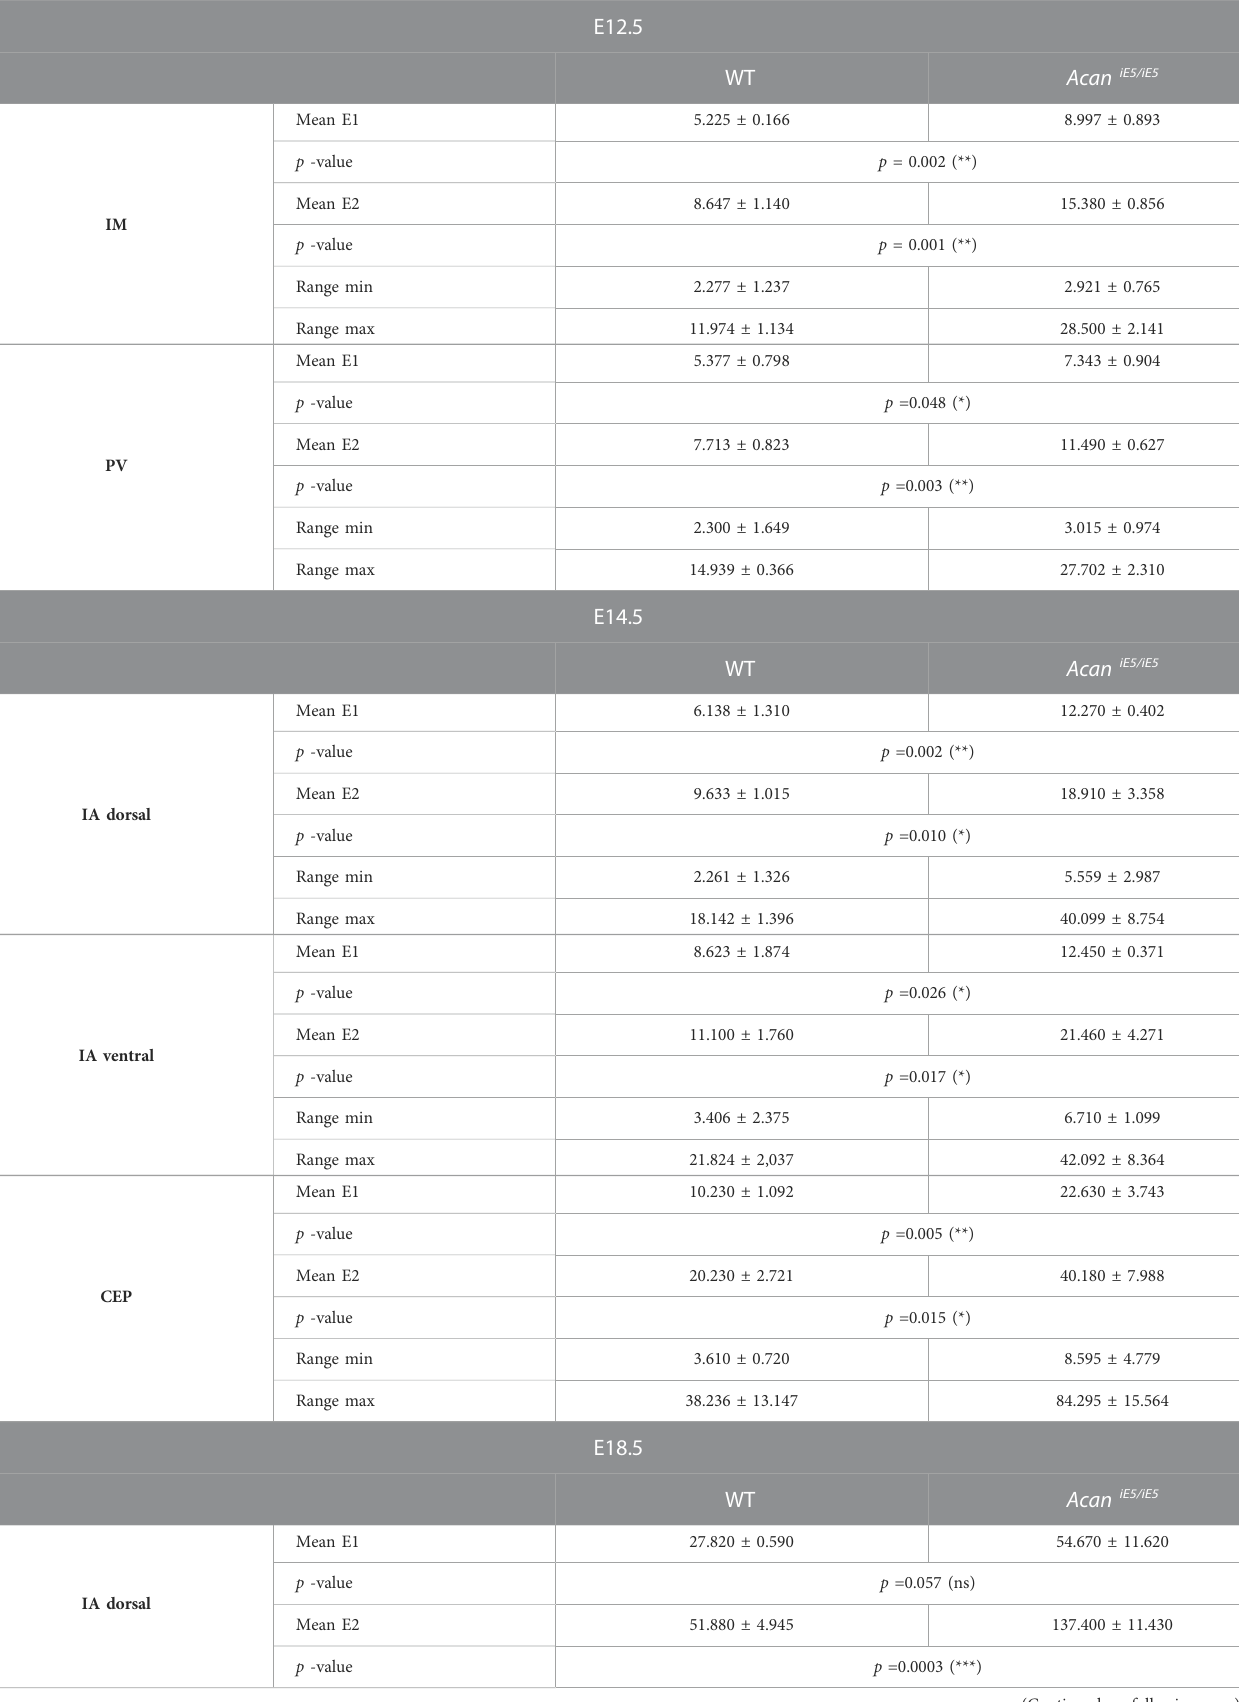
TABLE 1 Summary of the calculated mean elastic moduli at the E12.5, E14.5 and E18.5 in the developing IVD